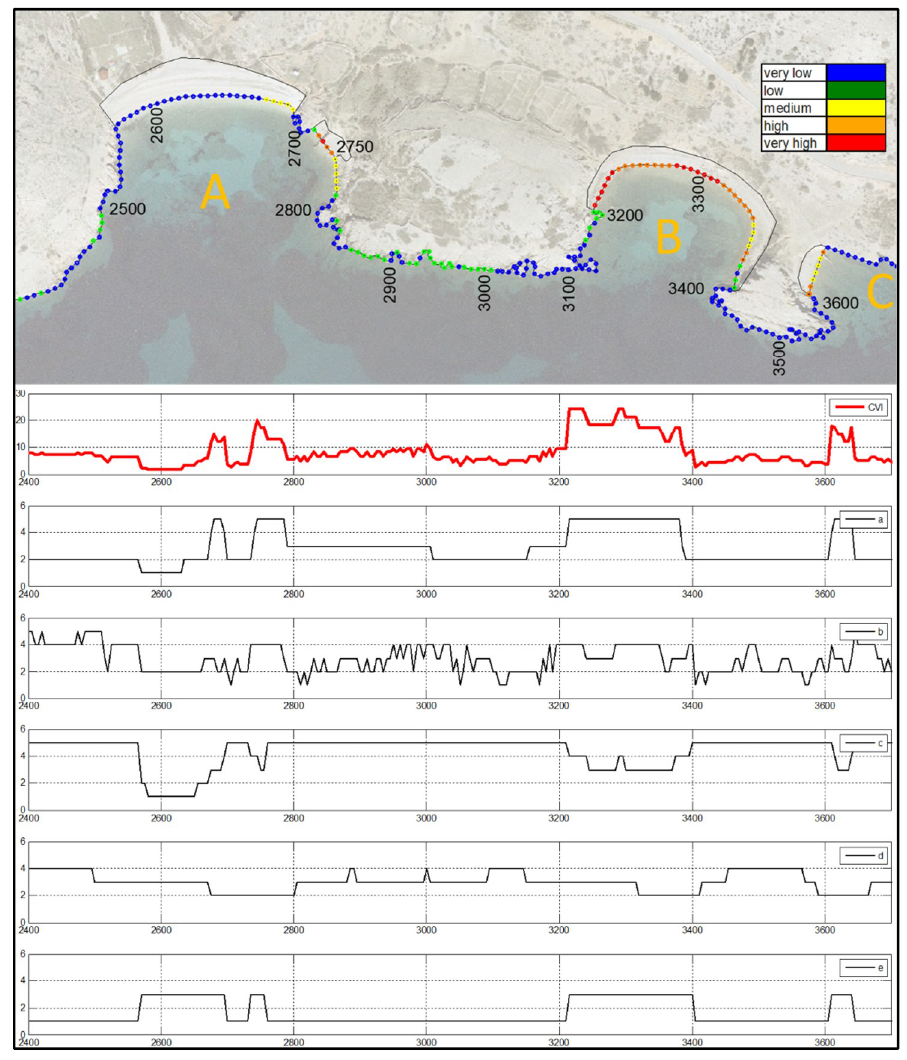
Figure 9. The results of the vulnerability assessment in the northwestern part of the research area: total CVI index; ( a ) Geological fabric; ( b ) Coastal slope; ( c ) Emerged beach width; ( d ) Significant wave height; ( e ) Land use.